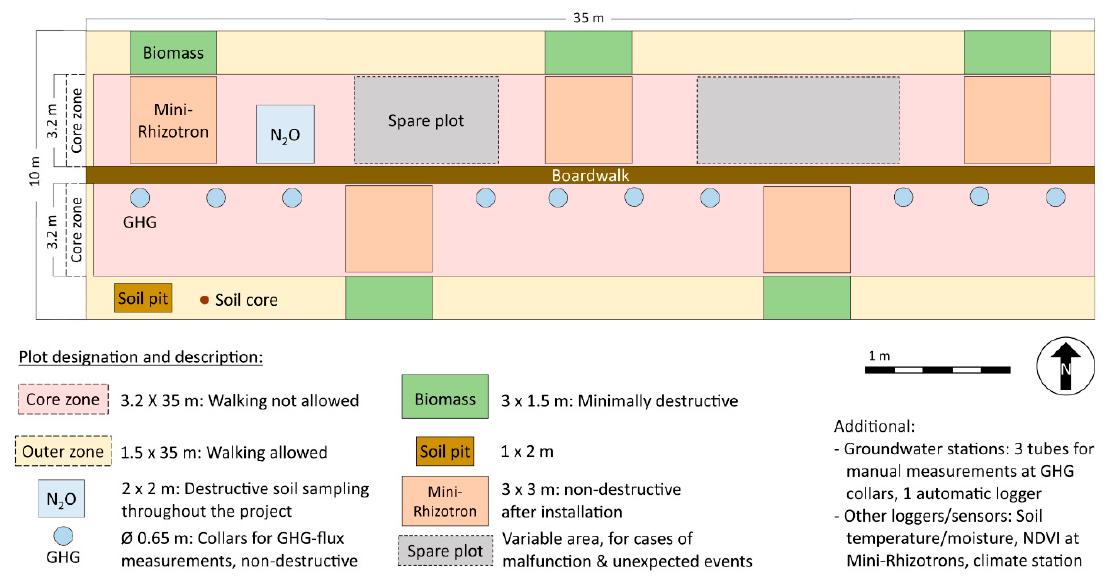
Figure 3. General characteristics of the WETSCAPES study sites.